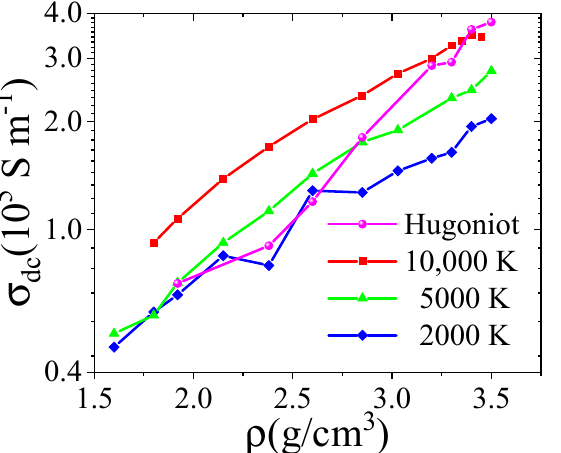
Figure 8. The dc conductivity σ dc of warm dense NO as a function of density along different iso- therms and the principal Hugoniot using PBE functional. and the principal Hugoniot using PBE functional.